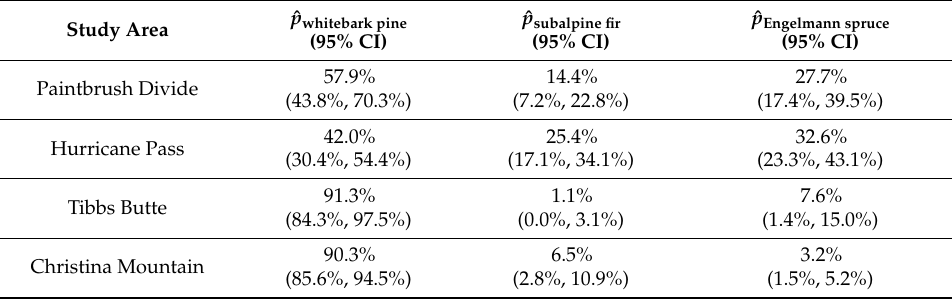
Table 4. Overall community composition parameter